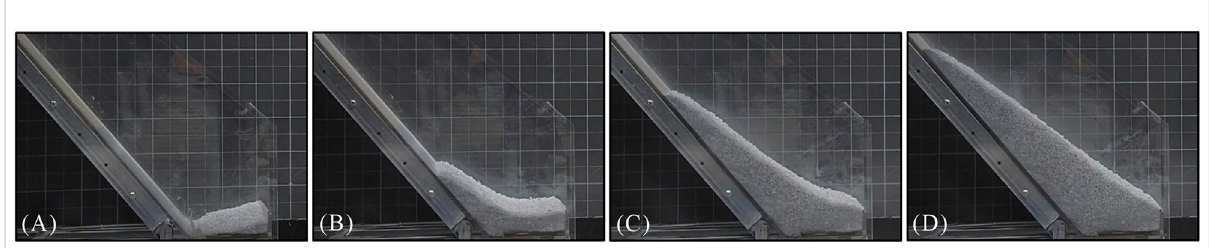
FIGURE 5 Developmentprocessesofagranularslopecon fi nedbyaretainingwall (A) debrisaccumulationbehindthewall; (B) debrisaccumulationonthe slope; (C) granular slope extension; (D) critical slope